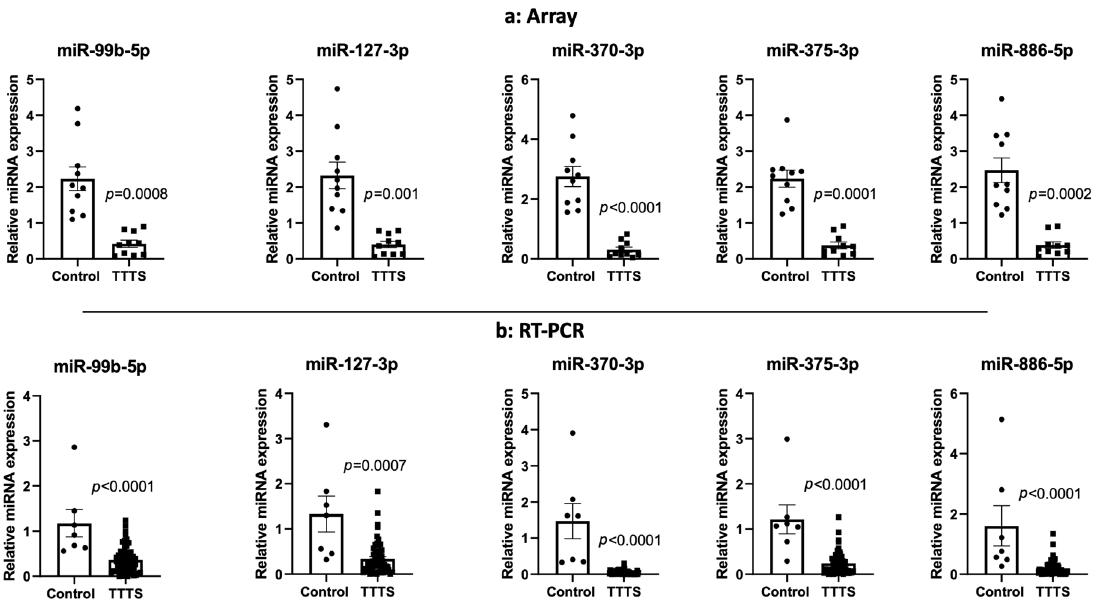
Figure 3. Bar graphs of 5 differentially expressed miRNAs from miRNA arrays ( a ) and RT-PCR ( b ). p -values displayed reflect individual comparisons. Individual miRNAs selected based on q < 0.0025. ( a ) Relative miRNA expression of select miRNAs among TTTS subjects n = 10 and singleton controls n = 10. ( b ) Relative miRNA expression of select miRNAs by RT-PCR utilizing miRNA-363 as a normalizer. TTTS n = 50, singleton controls n = 7.